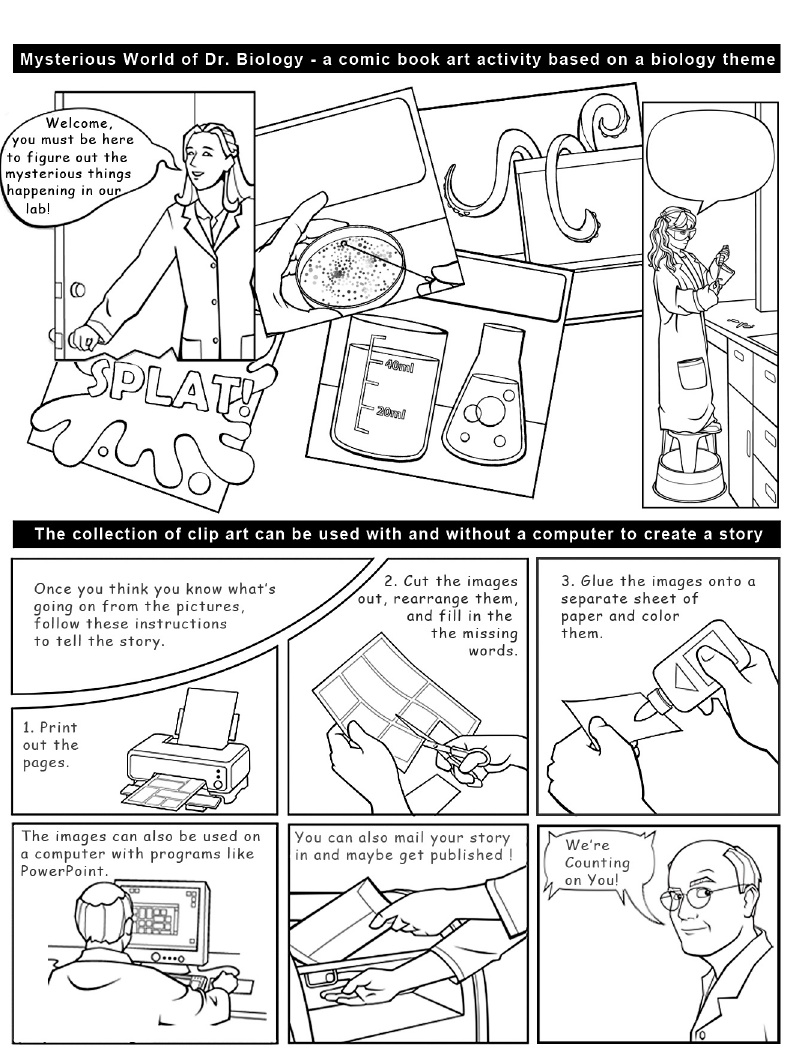
Figure 2. Mysterious World of Dr. Biology—Students can create their own adventure using the biology-focused clip art collection. The activity encourages writing and story development. Illustrations: Sabine Deviche.